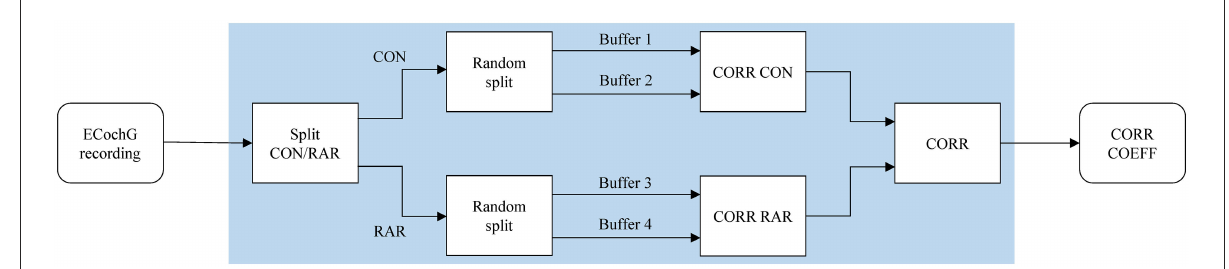
FIGURE2 The correlation analysis handles CON and RAR recordings separately and proceeds as follows: (i) the ECochG recordings are divided into CON and RAR; (ii) CON and RAR are each divided into two randomly arranged buffers of the same size (Buffers 1–4, 50 epochs each); (iii) the Pearson correlation coefficients for CORR CON and CORR RAR are calculated from buffer 1 and 2 and buffer 3 and 4, respectively; (iv) CORR is calculated from the mean of CORR CON and CORR RAR. Since CORR depends on the subdivision of buffers, steps ii–iv (shaded area) are repeated 100 times and averaged to get the final correlation coefficient CORR COEFF. CON, condensation; RAR, rarefaction; CORR, correlation; COEFF, coefficient.